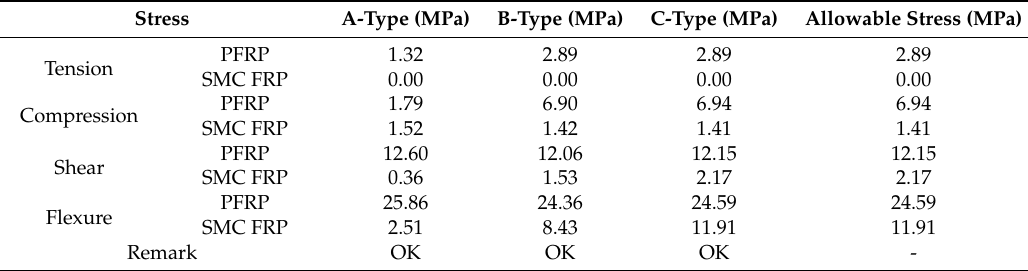
Table 4. FE analysis